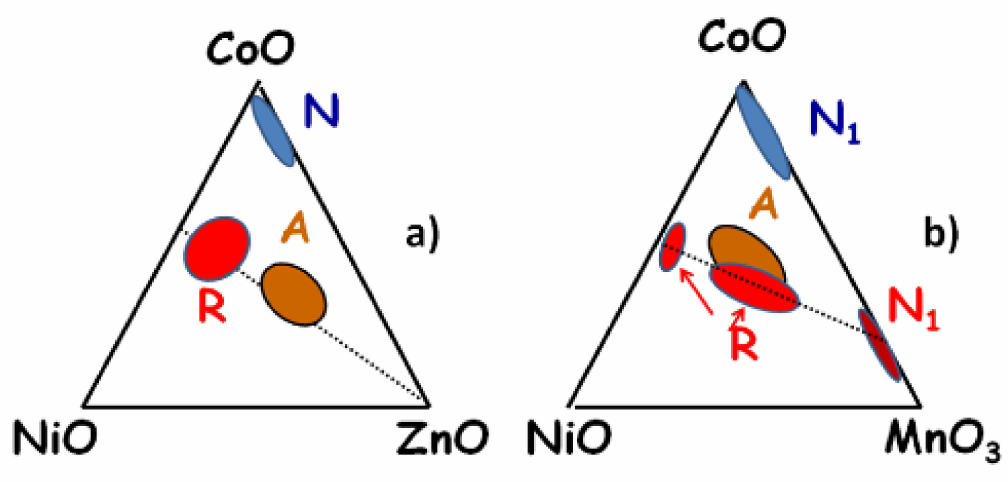
Figure 5. Ternary diagrams of the oxide compositional ratios of the transition metals in the cobalt-blue artifacts from Dahshur North (Egypt, 18th Dynasty, ca. 1450 BCE) and Northwest Saqqara (19th Dynasty, ca. 13th-Century BCE): ( a ) ratios of CoO, NiO, and ZnO, ( b ) ratios of CoO, NiO, and MnO 3 . Diagrams for bulk glass and faience glaze are redrawn after Abe et al. [191]. Type A is observed for faience. Types N (N 1 & N 2 subgroups) are from the Late/Ptolemaic/Roman